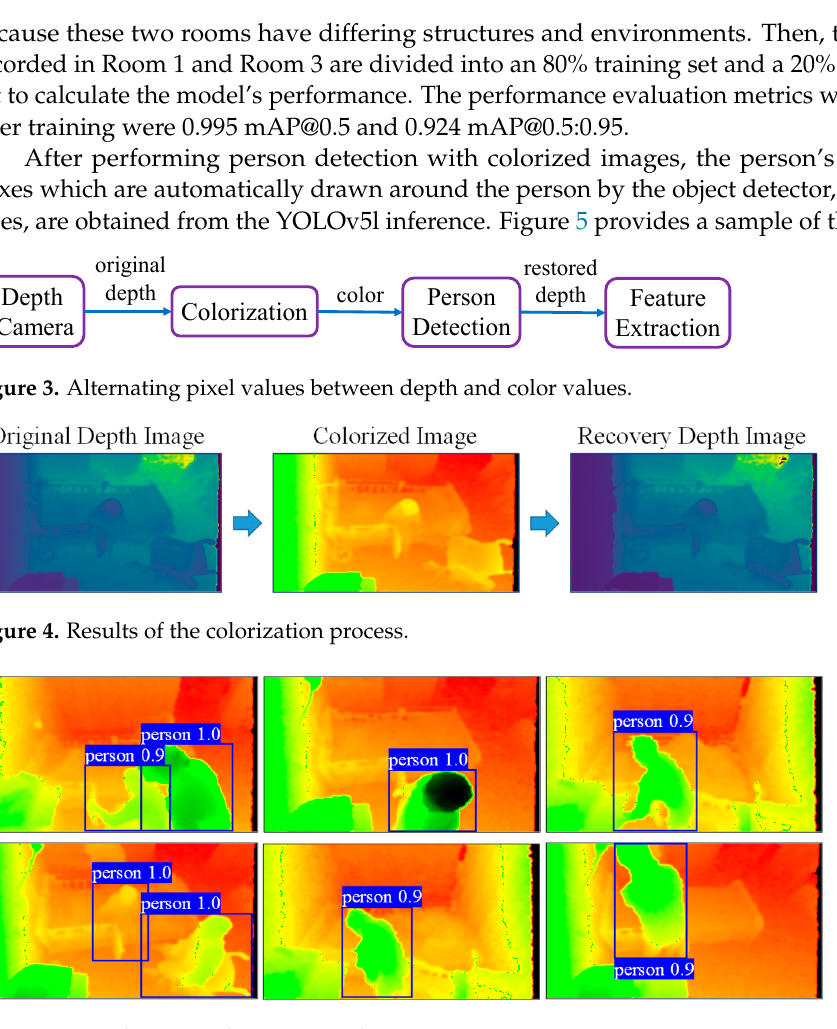
Figure 5. Sample person detection results.